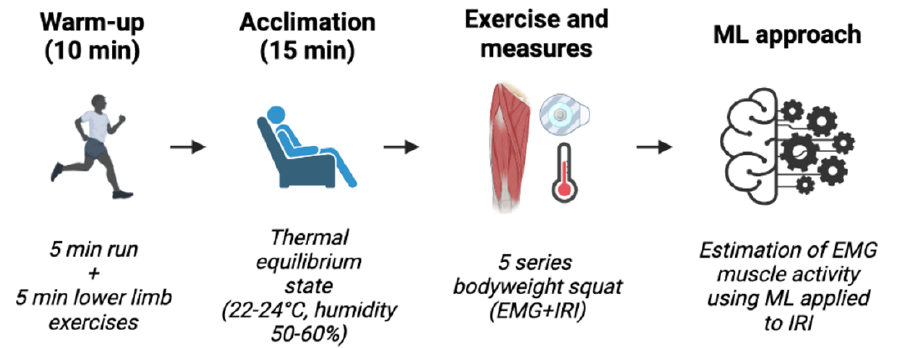
Figure 1. Schematic overview of the testing session. The figure is created with BioRender.com, EMG: electromyography; IRI: infrared thermal imaging; ML: machine learning.